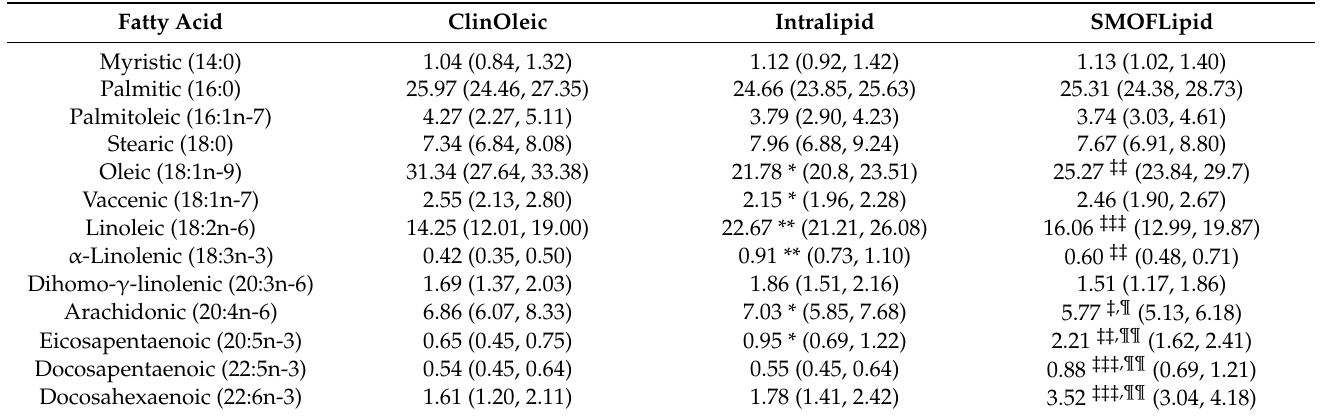
Table 4. Plasma fatty acid composition (% of total fatty acids) in patients receiving different lipid emulsions. Data are median (interquartile range).